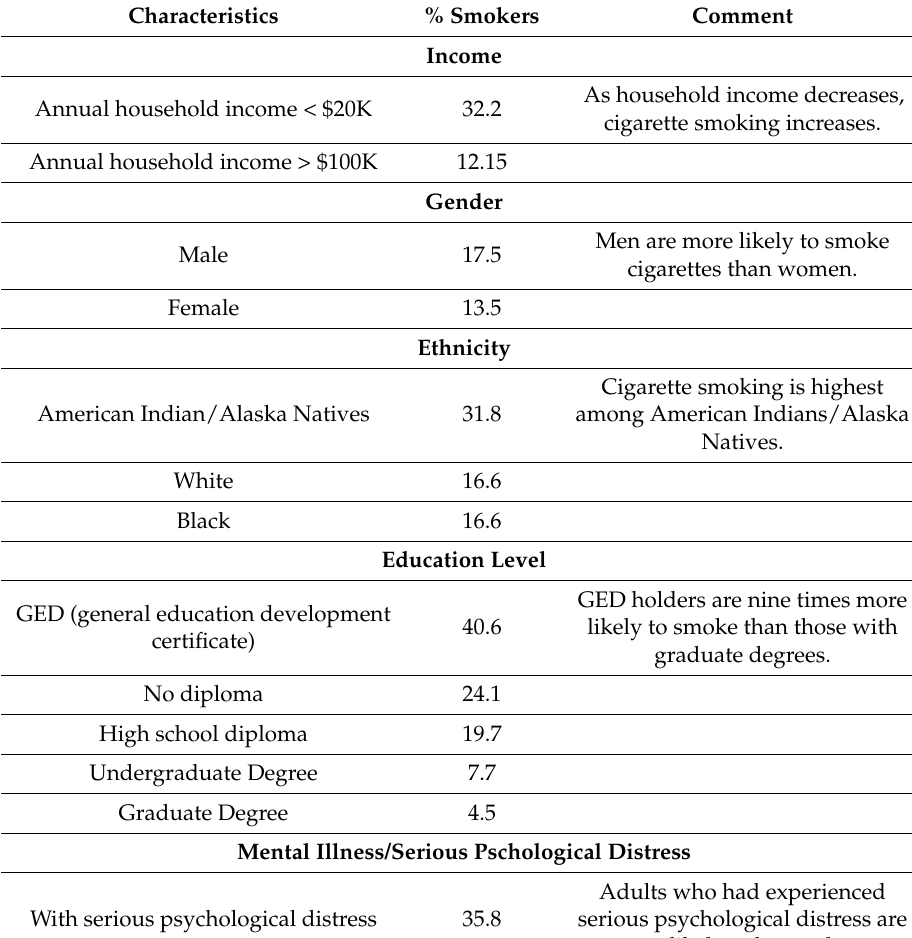
Table 1. Cigarette Smoking in Selected